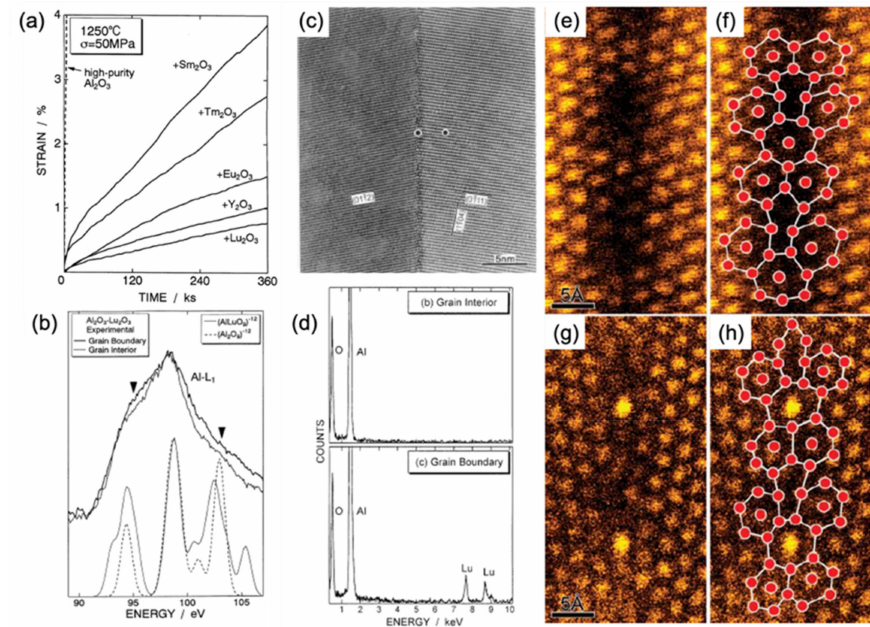
Figure 40. ( a ) High temperature creep properties of pure Al 2 O 3 and different Ln oxides-doped Al 2 O 3 ; ( b ) ELNES Al-L 1 edge peak for Lu 2 O 3 -doped Al 2 O 3 in the grain interior and at a GB. ( c ) HRTEM micrograph of a GB in Lu 2 O 3 -doped Al 2 O 3 . ( d ) EDXS point spectra from the grain interior and the GB, corresponding to the two points in ( c ). ( e , g ) are HAADF STEM images of a Σ 31 [0001] tilt GB in pure Al 2 O 3 , Y-doped Al 2 O 3 , respectively. Brighter columns in ( g ) are the locations of segregated Y atoms. ( f , h ) are the same images as in ( e , g ), respectively, and with schematic overlay to show the arrangement of atomic columns. It is observed that Y atoms are at the center of the seven-member ring units along the GB [200]. Figure 40a–d reprinted from Materials Science and Engineering: A, Impurity effects on grain boundary strength in structural ceramics, Yuichi Ikuhara, Hidehiro Yoshida, Taketo Sakuma, 2001, 24–30, with permission from Elsevier. Figure 40e–h reprinted from Grain Boundary Strengthening in Alumina by Rare Earth Impurities, J. P. Buban, K. Matsunaga, J. Chen, N. Shibata, W. Y. Ching, T. Yamamoto, Y. Ikuhara, Science 2006, 311, 212–215. Reprinted with permission from